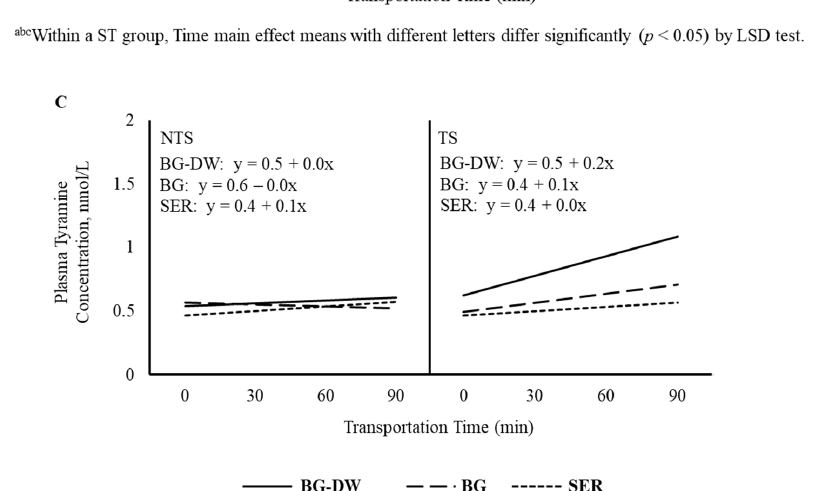
Figure 5. ( A ) Effects of Diet (BG-DW: bermudagrass hay—dewormed; BG: bermudagrass hay; SER: sericea hay; p = 0.07) and ( B ) Stress Treatment (ST; NTS: non-transported; TS: transported), and Time (Time, p < 0.05; ST × Time, p < 0.05) on plasma tyramine concentrations in goats. ( C ) Polynomial contrasts showing a significant linear trend ( p < 0.01) over Time.